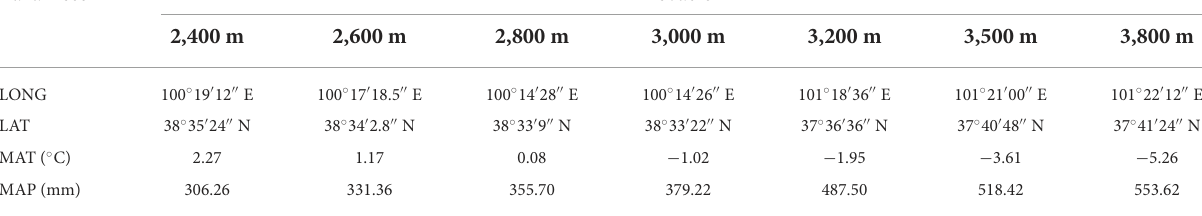
TABLE 1 Sampling site coordinates, mean annual temperature (MAT), and precipitation (MAP) in the study area. Parameter